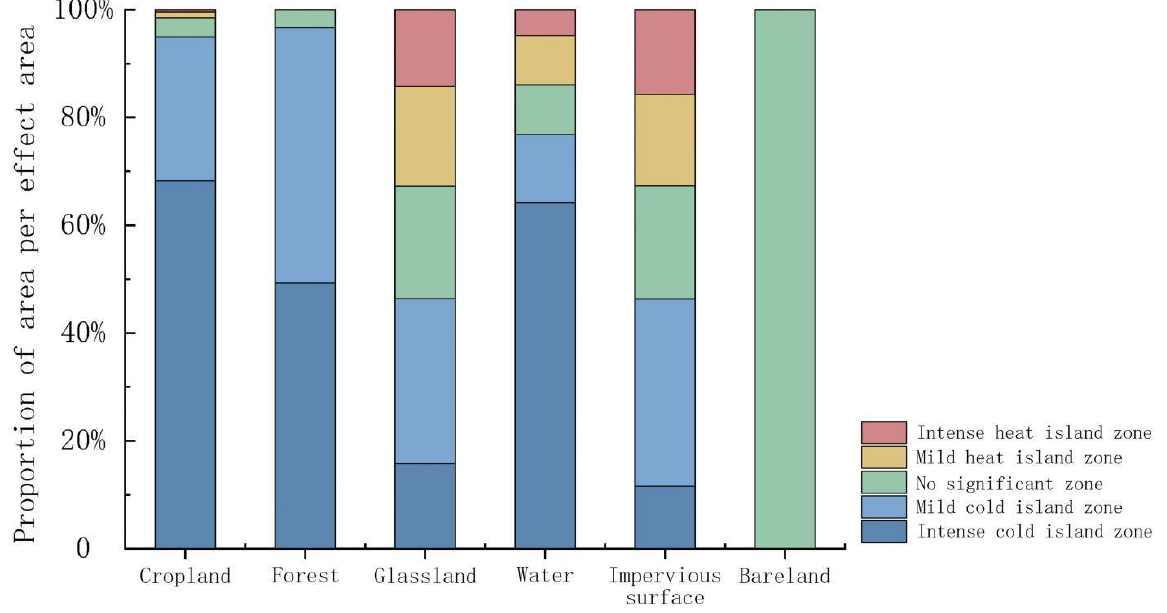
Figure 5. Scale diagram of UHII for different land cover types in 2019